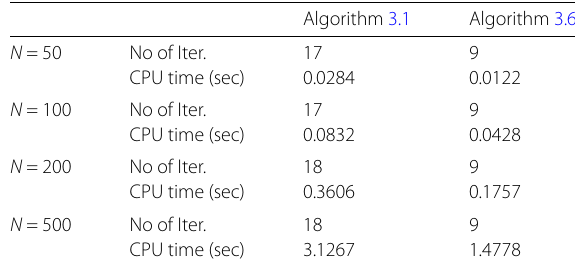
Table 3 Computation result for Example 4.3